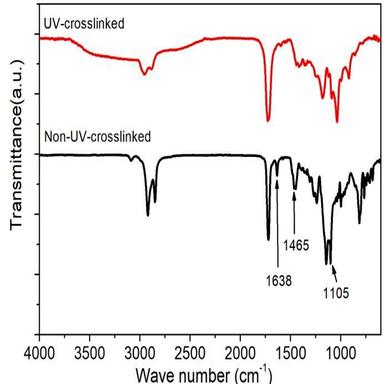
Infrared spectra comparison of PEO-PFc-PCA before and after illumination with LED UV lamp (310 nm, 12 W) for 50 min.